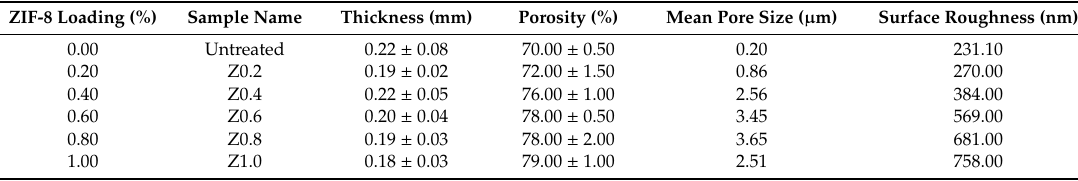
Table 1. Membrane properties of untreated nylon 6,6 NFM and nylon 6,6 / ZIF-8 NFM.